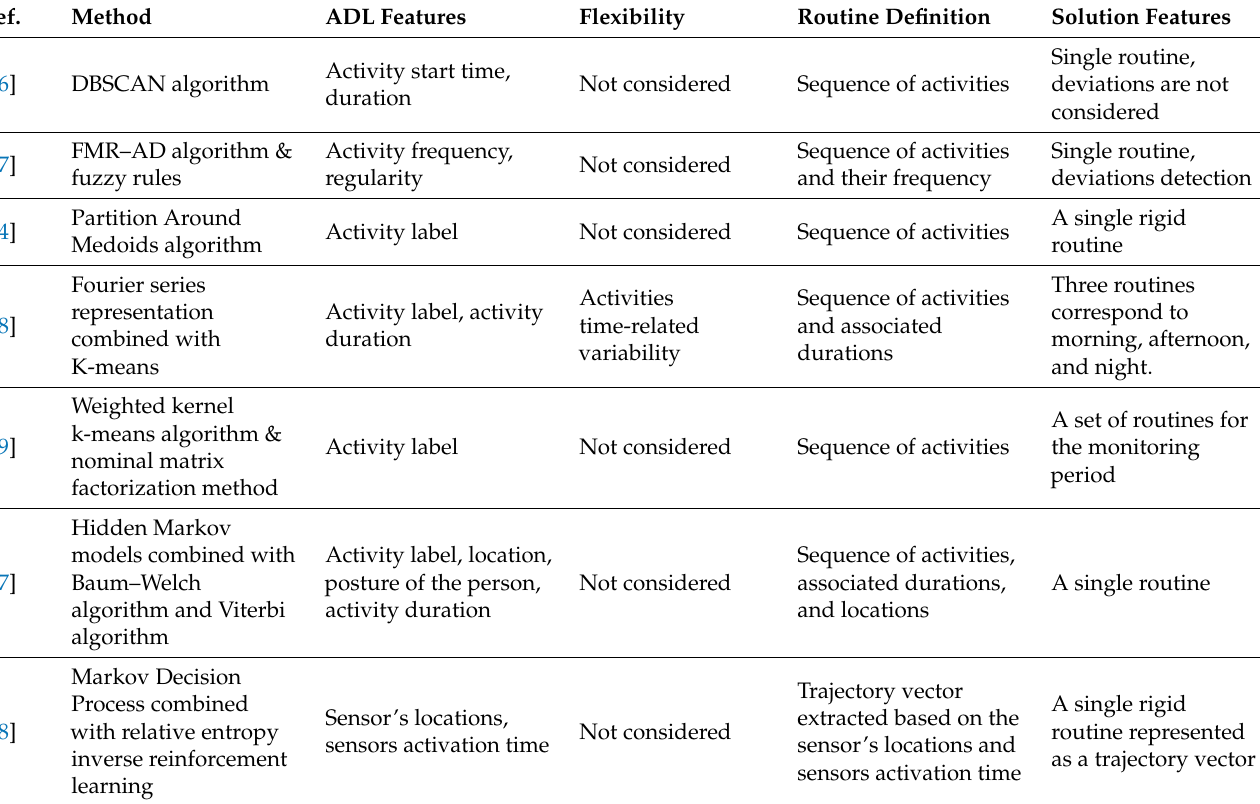
Table 2. Comparison of research literature